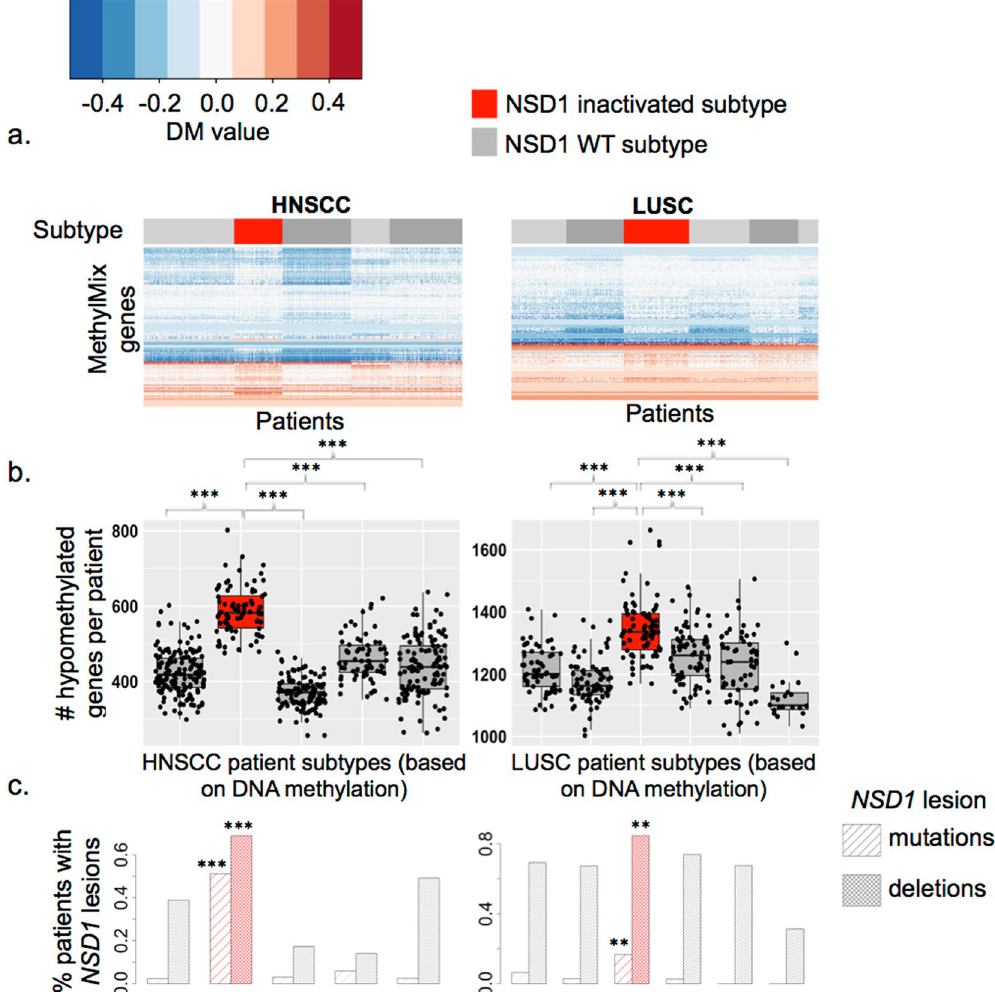
Figure 1. Identification of NSD1 inactivated subtypes of squamous cell carcinomas featuring epigenetic de-repression of developmental oncogenes: ( a ) Heatmaps of differential methylation (DM) values illustrate five subtypes of head and neck squamous cell carcinoma (HNSC, n = 528 patients) and six subtypes of lung squamous cell carcinoma (LUSC, n = 502 patients) within TCGA studies, identified by consensus clustering of patients according to their profiles of abnormally methylated genes, subsequent to identification of these abnormally methylated genes by applying MethylMix to integrate DNA methylation and gene expression data. DM values represent the beta value difference in methylation between tumor and normal adjacent tissue for hypomethylated ( < 0) or hypermethylated ( > 0) methylation states for each gene, calculated by MethylMix 71 . Red bars demarcate hypomethylated NSD1 subtypes, while light and dark grey bars demarcate other subtypes. ( b ) The average number of genes hypomethylated per patient (in tumor relative to normal tissue) was significantly higher in NSD1 subtypes (red) than each other subtype (grey) in both HNSC and LUSC. ( c ) Percentages of patients within each subtype that have NSD1 mutations (Striped bars) and NSD1 deletions (Solid bars) in HNSC and LUSC. Asterisks indicate the significance of enrichment of NSD1 mutations or deletions within the NSD1 subtype (red) compared with patients in all other subtypes (Pearson’s chi-squared